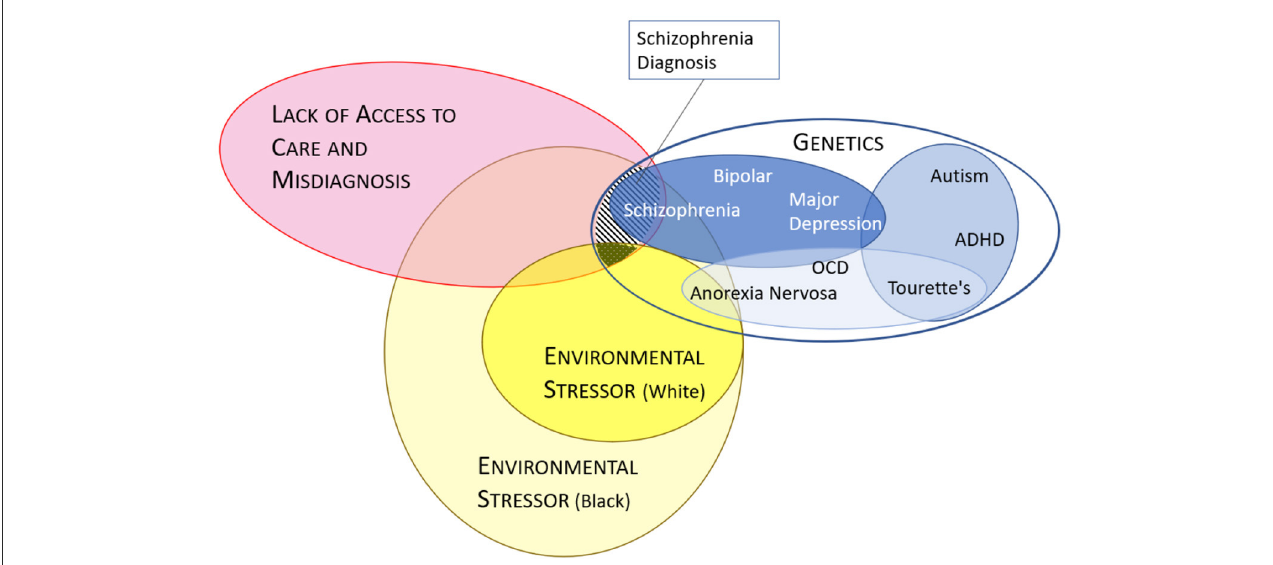
FIGURE2 Potential factors leading to higher observed diagnoses of schizophrenia. Model of how factors leading to a diagnosis of schizophrenia can differ between Black and White individuals taking into account differences in environment, access to care, misdiagnoses and genetics (15). Stripped area represents diagnoses of schizophrenia in Black populations which has been observed to be greater than in White populations (dotted area). The blue ovals (genetics) are based on a risk model from the Cross-Disorder Group of the Psychiatric Genomics Consortium (3). Misdiagnosis and lack of care (red oval) appears to affect racialized individuals (i.e., Black) more often than White individuals (intersecting orange